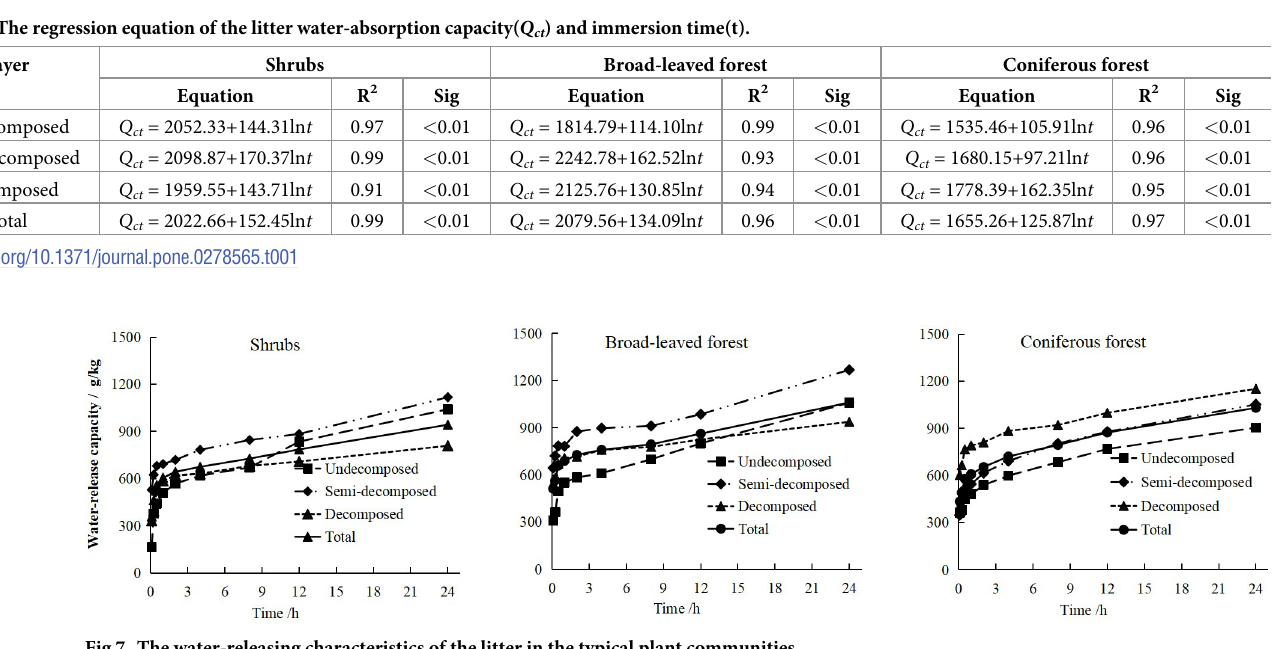
Table 1. The regression equation of the litter water-absorption capacity( Q